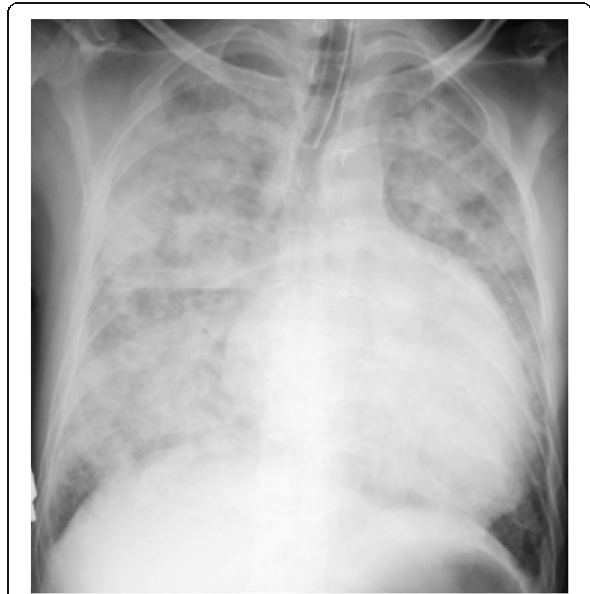
Fig. 1 Chest radiography shows pulmonary edema and an extremely dilated ventricular shadow at the onset of severe right ventricular failure